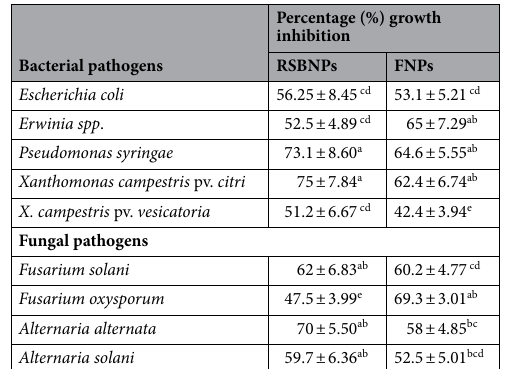
Table 5. In vitro percentage (%) growth inhibition of five different phytopathogenic bacteria and four fungal isolates by RSBNPs and FNPs.